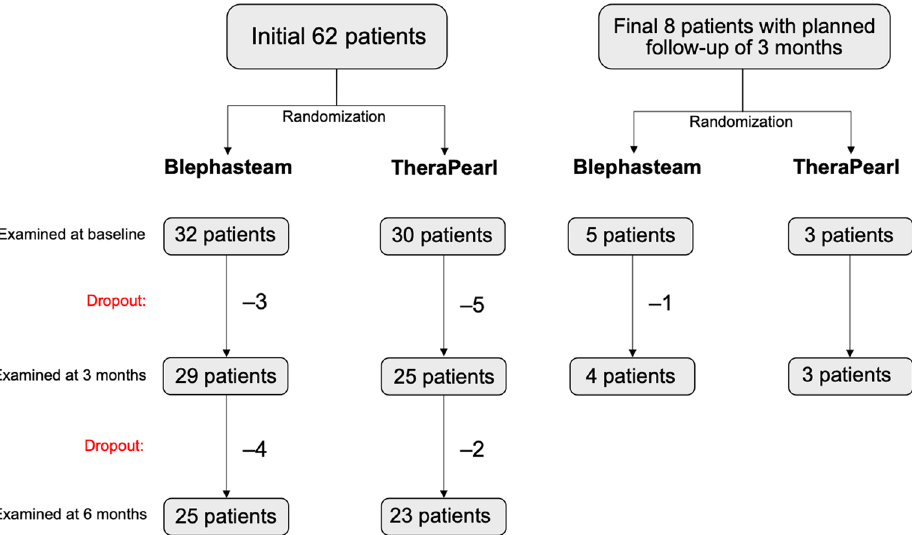
Figure 3. Patient inclusion, treatment allocation, and dropout. Figure created in PowerPoint version 16.53 (Microsoft, Washington, USA).